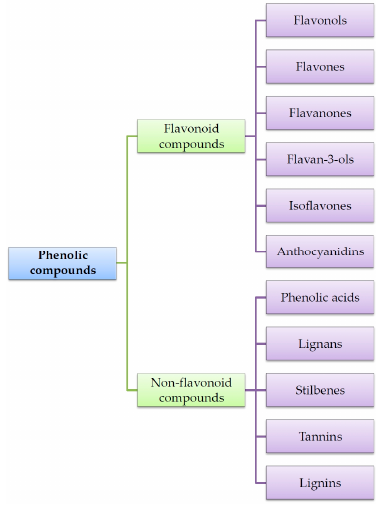
Figure 1. The classification of phenolic compounds.